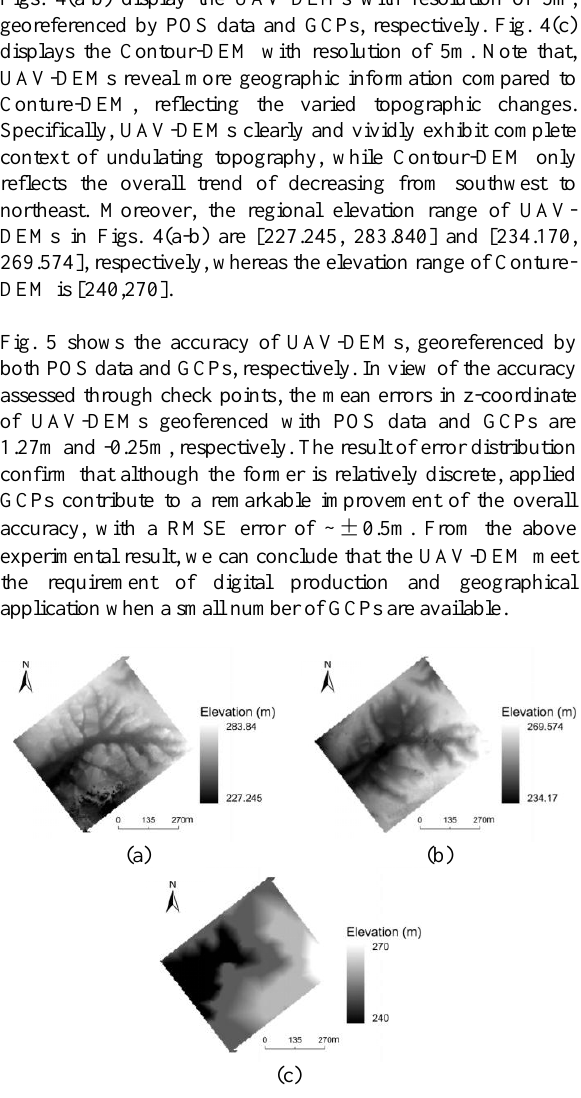
Table 2. Coordinate of the identification points